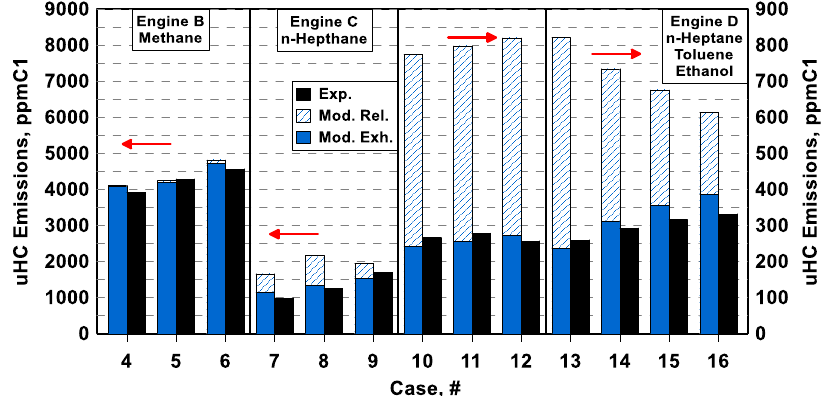
Figure 15. Comparison of engine-out uHCs emissions with the numerical outcomes before (Mod. Rel.) and after (Mod. Exh.) post-oxidation for Engines B, C, and D.